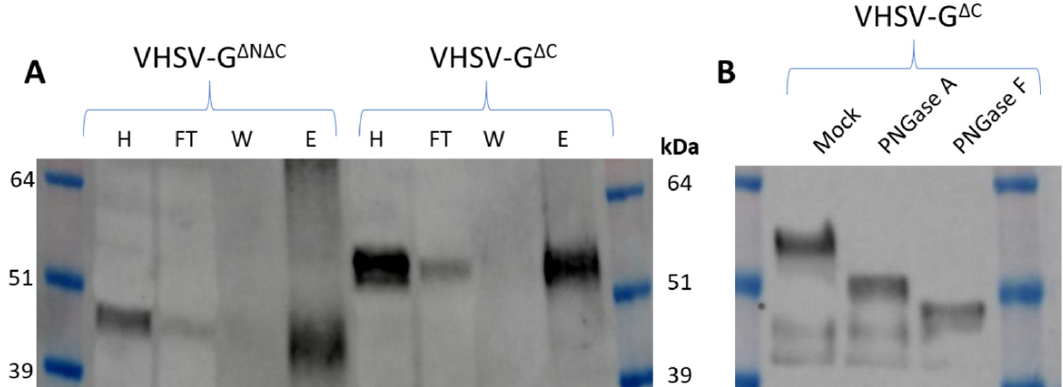
Figure 3. VHSV G protein produced in plants is glycosylated. His-tagged N- and C-terminally truncated G protein (VHSV-G ∆ N ∆ C ) and C-terminally truncated G protein (VHSV-G ∆ C ) were transiently expressed in N. benthamiana . The N-terminal truncation removes the native secretion signal and hydrophobic region, while the C-terminal truncation removes the transmembrane domain. ( A ) Anti-G Western blot of homogenate (H), flow-through (FT), wash (W) and elution (E) fractions of nickel column affinity purification for both constructs. ( B ) anti-G Western blot of affinity-purified VHSV-G ∆ C after mock deglycosylation treatment or treatment with PNGase A and F. The band shift is indicative of glycosylation.